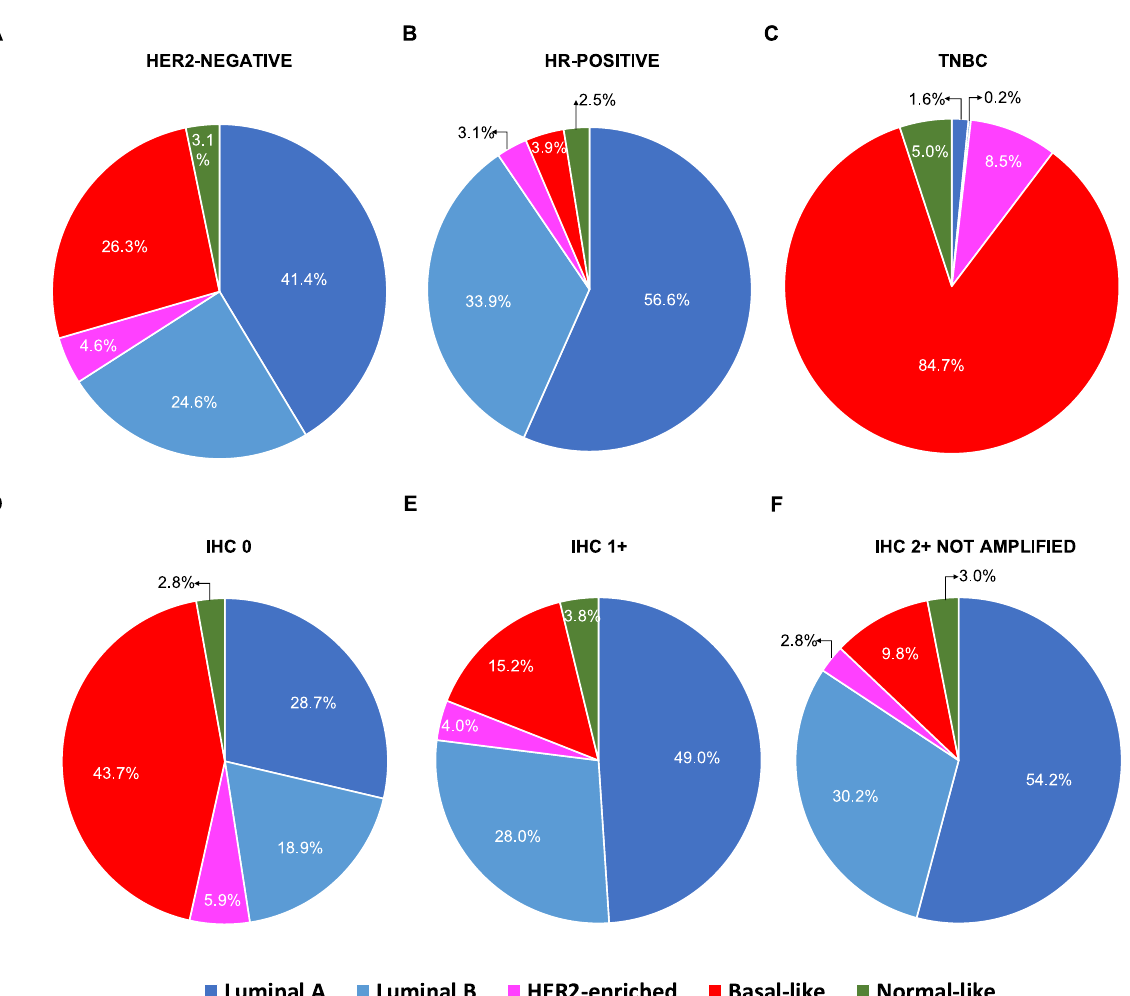
Fig. 3 Intrinsic subtype distribution according to HER2 status and HR status. HR hormone receptors, TNBC triple-negative breast cancer, IHC immunohistochemistry, ISH in situ hybridization (including either FISH, SISH, and CISH). Number of patients in A ( n = 1576), B ( n = 1137); C ( n = 437); D ( n = 673); E ( n = 701); F ( n =